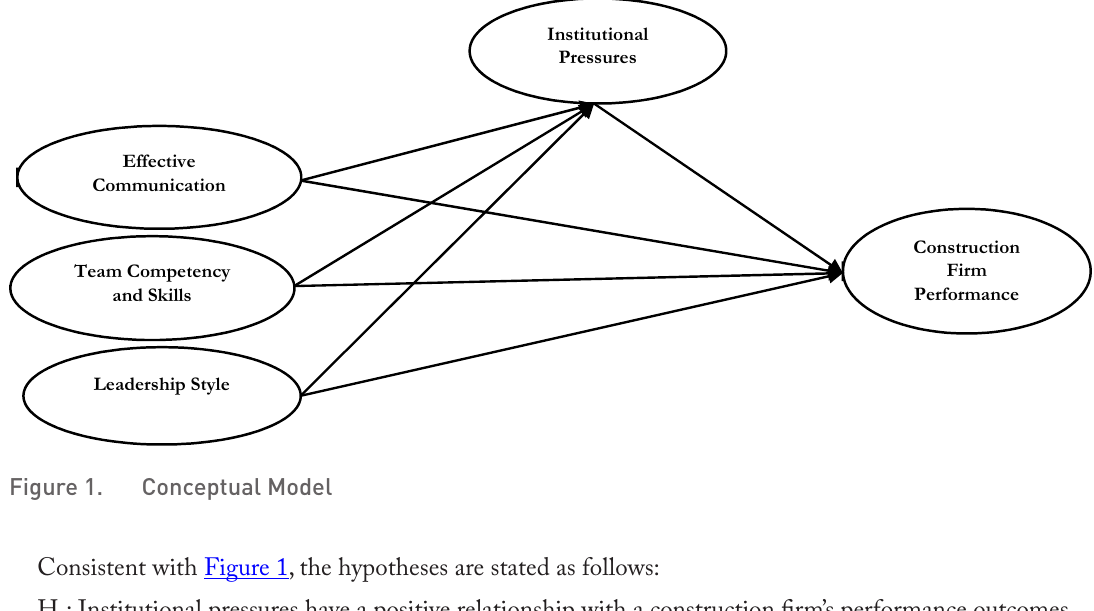
Figure 1. Conceptual